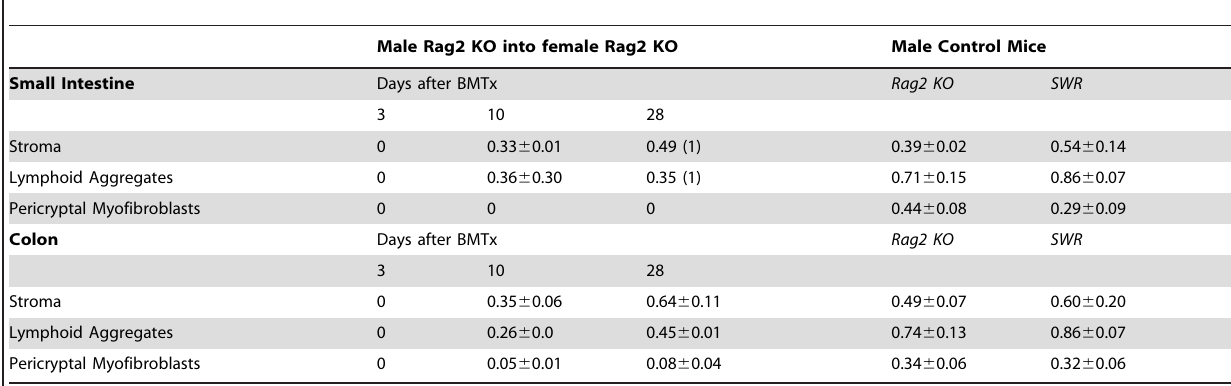
Table 2. Proportions of Y chromosome-positive cells in intestines of female Rag2 KO mice receiving male Rag2 KO Bone Marrow and of aged-matched untreated male control Rag2 KO and SWR